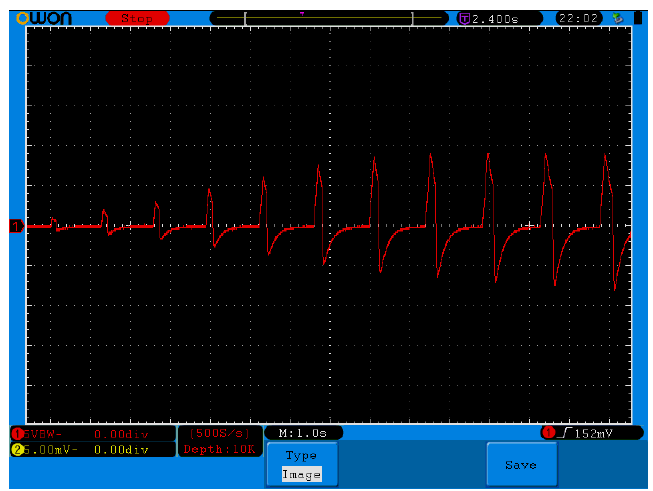
Figure 4. Z travel 1 mm per second with pre-travel and after-travel. Vertical 2 V per cm, Horizontal 50 ms per cm.